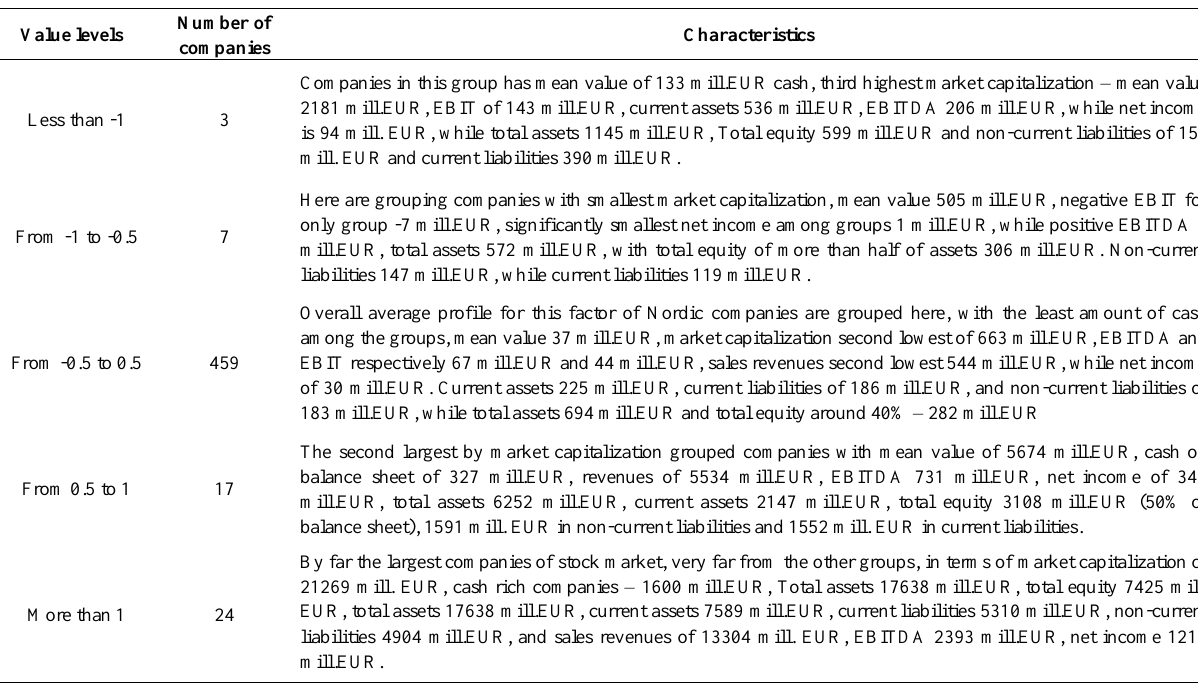
Table 4. Detailed characteristics of Complex factor 1 – Overall business operations .